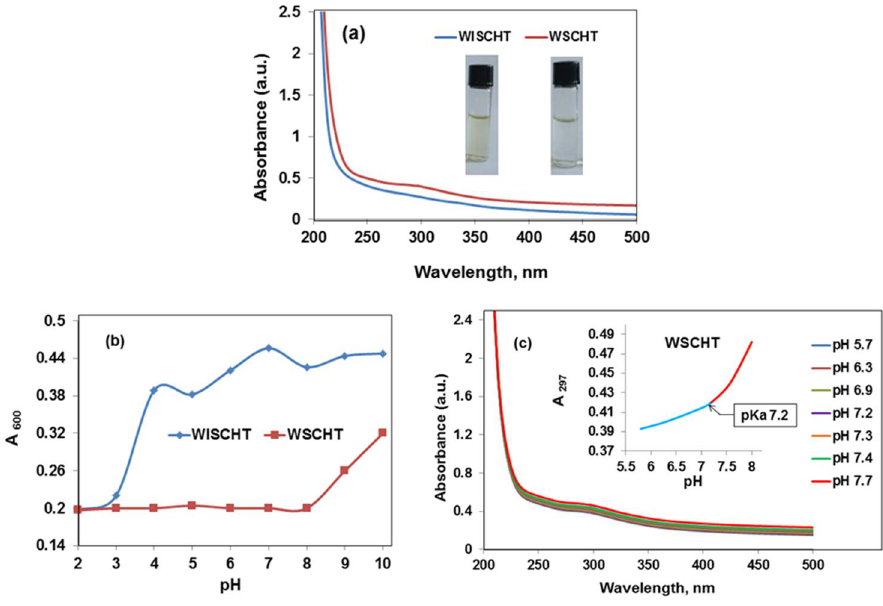
Figure 2. ( a ) UV-Vis spectra, ( b ) pH dependence solubility, and ( c ) pKa value.